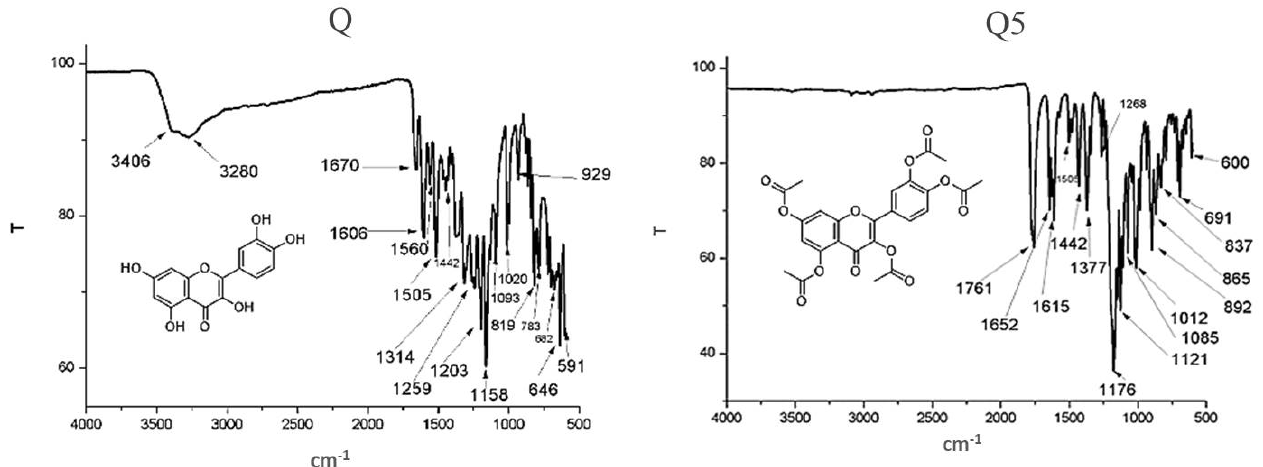
Figure 1. FTIR spectrum of the compounds Quercetin (Q) and Quercetin pentaacetate (Q5), demonstrating the disappearance of representative hydroxyl bands next to 3280 cm − 1 and the appearance of bands close to 1761 cm − 1 assigned to acetyl groups.